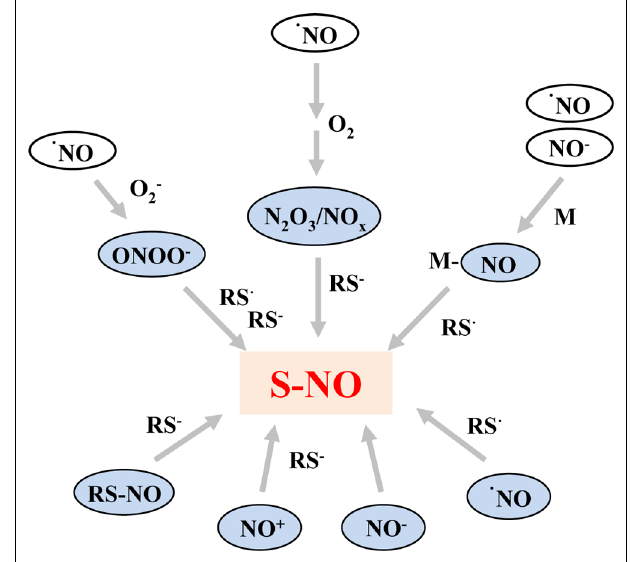
FIGURE 1 | Summary of the most important pathways resulting in formation of S -nitrosothiols. NO as free radical ( · NO) reacts primarily with superoxide ( O − 2 ), oxygen (O 2 ), and redox metals (M) resulting in formation of S -nitrosylating agents, such as peroxynitrite (ONOO − ), NO oxides (N 2 O 3 /NO x ), or metal–NO complexes (M–NO).The latter can also be formed by the reaction of nitroxyl anions with redox metals. Furthermore, NO radicals can react directly with thiyl radicals (RS · ). Moreover, the oxidized nitrosonium cation (NO + ) and the reduced nitroxyl anion (NO − ) can act as S -nitrosylating agents. However, the direct reaction between thiols and NO − is dependent on the energy state of NO − and occurs only when NO − is present in the high energy singlet state.The thiol groups and thiyl radicals can either be part of a protein or a low molecular weight compound such as